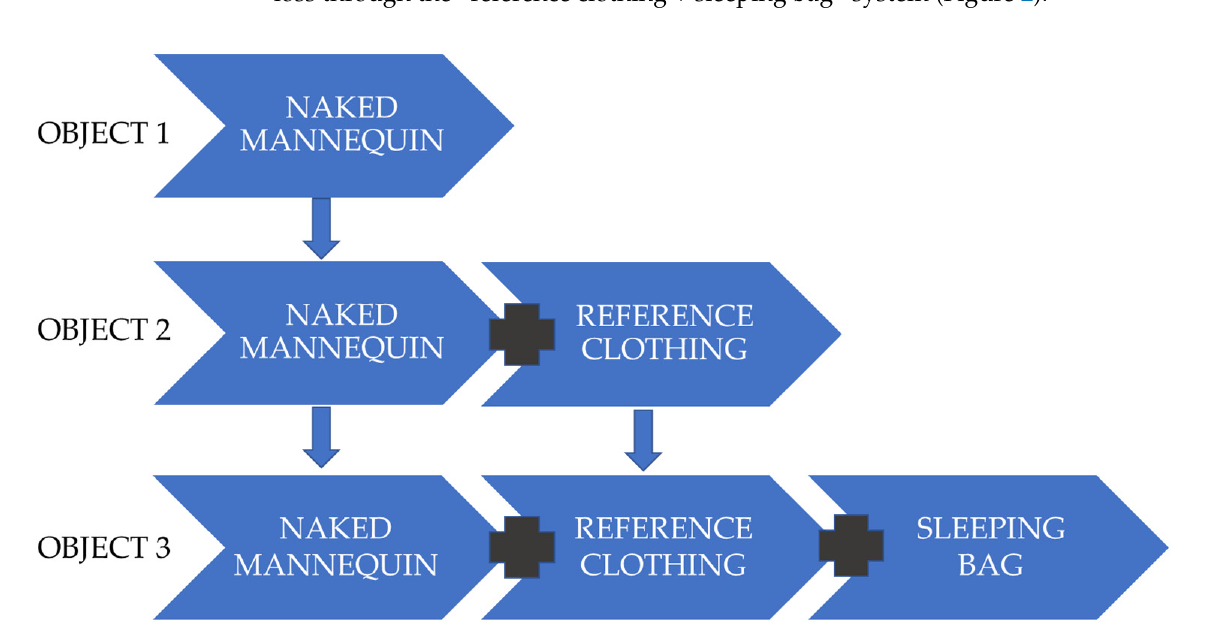
Figure 2. Graphical representation of the objects tested.